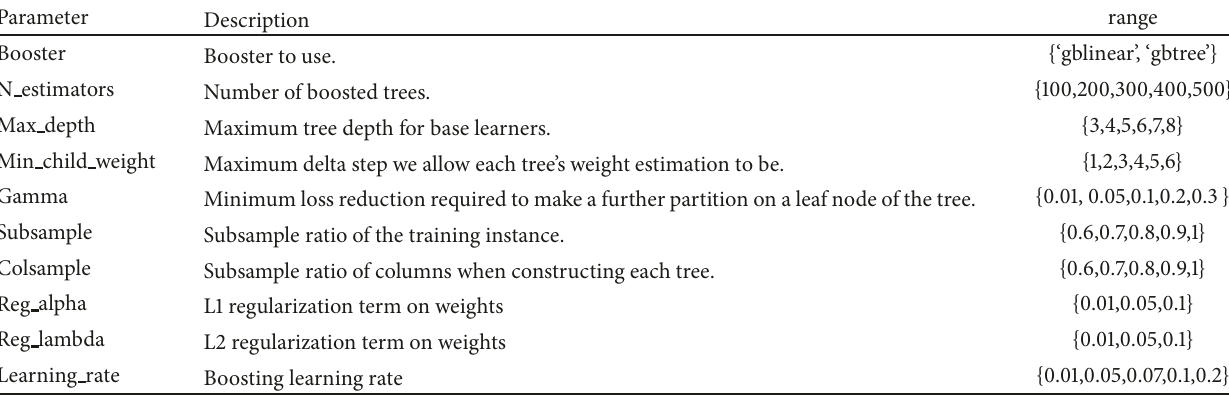
Table 1: The ranges of the parameters for XGBOOST by grid search.